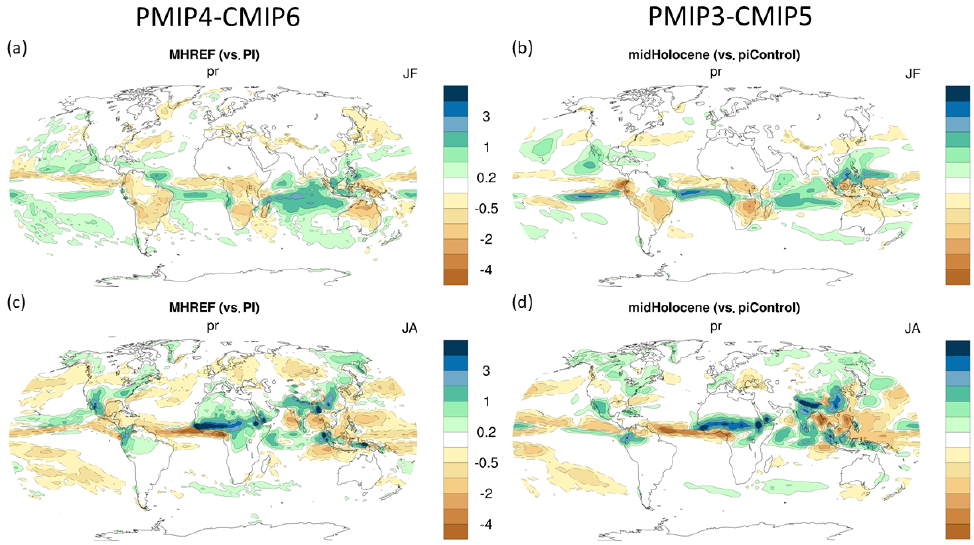
Figure 5. Same as Fig. 4 but for precipitation (pr, mmd − 1